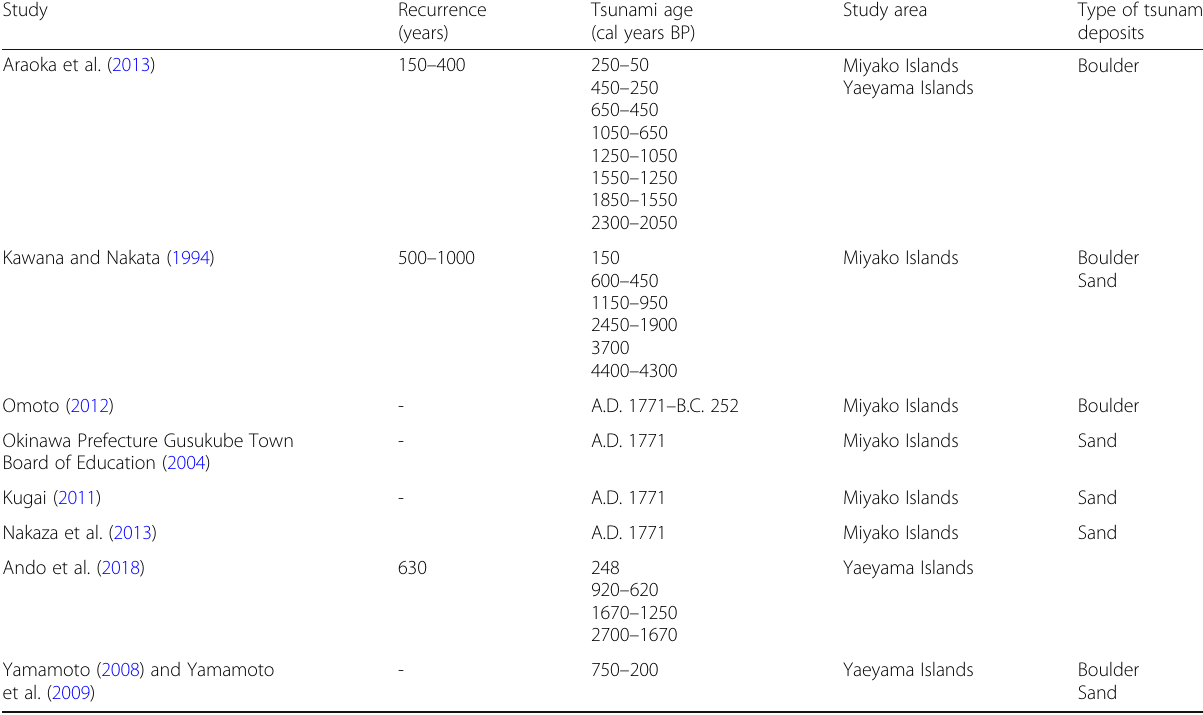
Table 1 Representative paleotsunami history in Miyako and Yaeyama Islands Study Recurrence